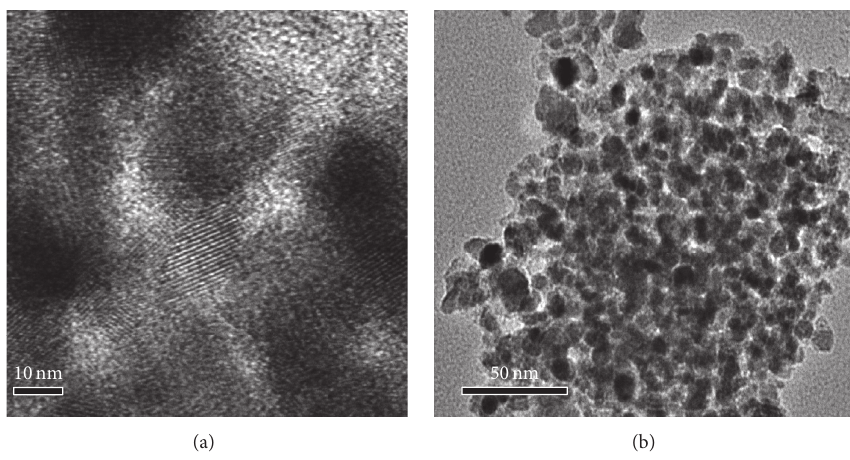
Figure 4: TEM images of mesoporous Ta 3 W 7 oxide (stearic acid).